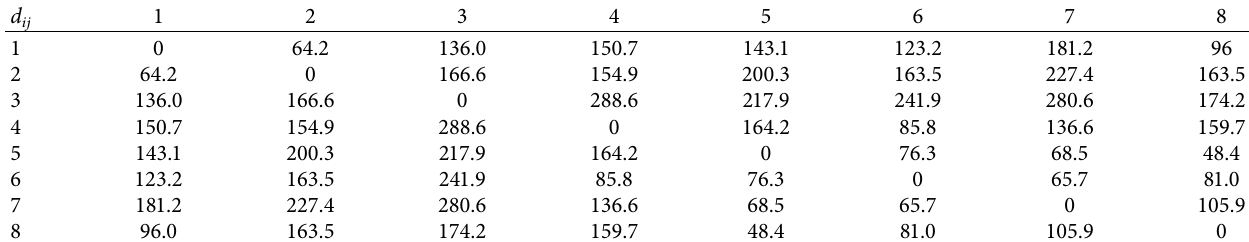
ij between cities (unit: